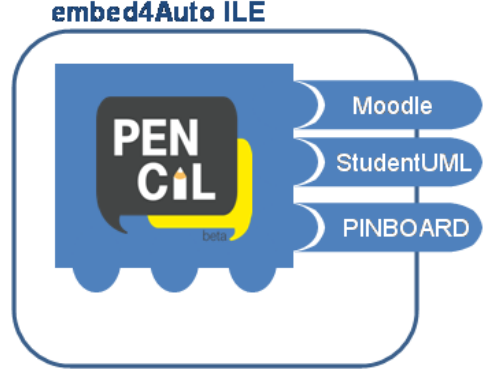
Figure 1. The high-level overview of the Embed4Auto